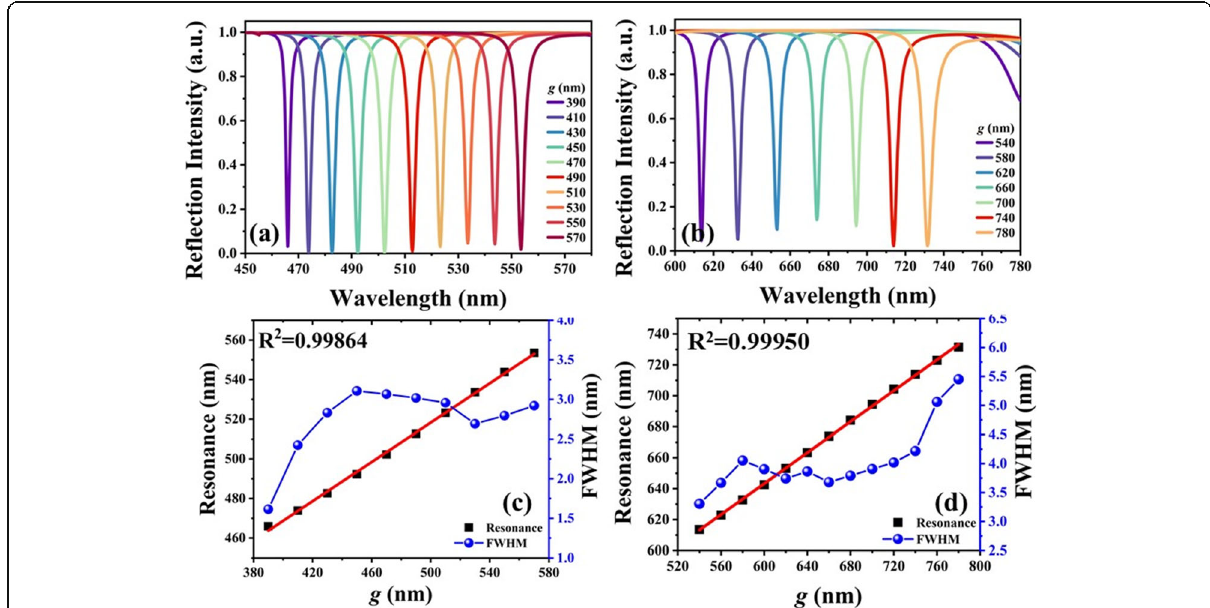
Fig. 5 Reflection spectra of TLNM. Parameters are optimized for the maximum tunable range under the conditions of a D y = 350 nm, t = 210 nm, b D y = 450 nm, t = 280 nm. c , d The relationships of resonances, g values, and corresponding FWHM values of a and b ,